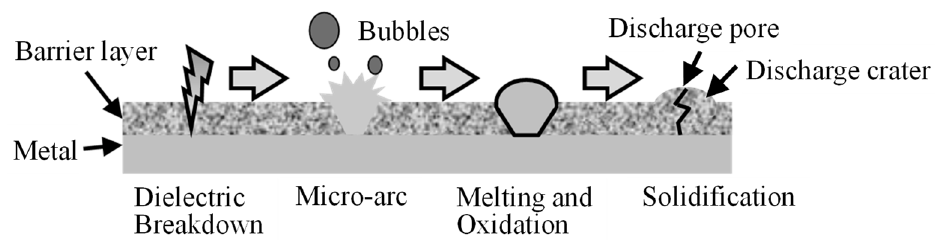
Figure 1. Formation process of PEO coating.